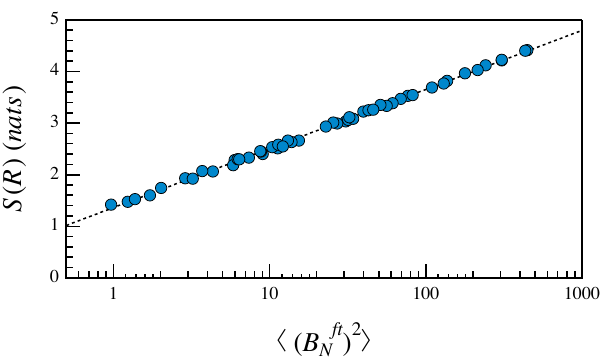
Figure 6. The Shannon entropy S ( R ) of the filtered normal component of the magnetic field versus the mean squared value of the filtered normal component.